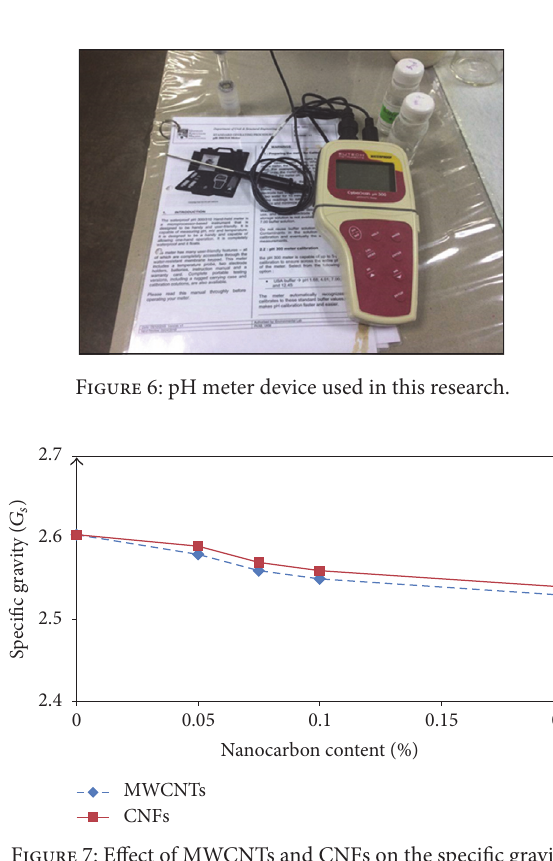
Figure 7: Effect of MWCNTs and CNFs on the specific gravity.